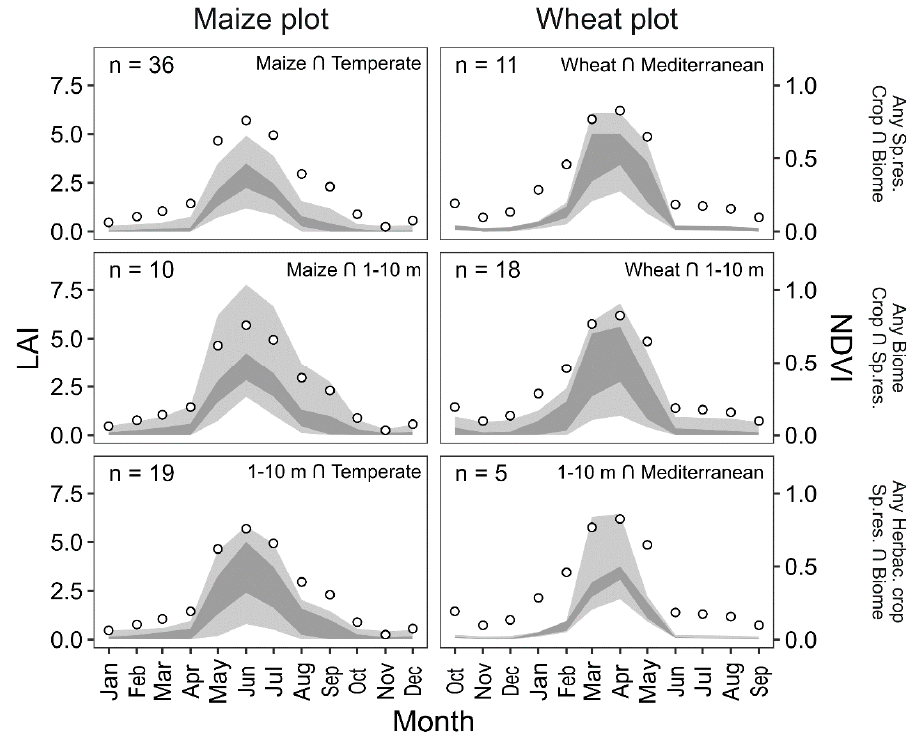
Figure 5. Leaf area index (LAI) seasonal profile of the case studies, computed from normalized difference vegetation index (NDVI, dots) values according to the equations derived from the following combinations of attributes: ( top ) crop- and biome-specific equations; ( middle ) crop- and spatial resolution-specific equations; ( bottom ) biome- and spatial resolution-specific equations. The grey shadows indicate the 5–95th (light grey) and the 25–75th percentile (dark grey) of the LAI values obtained from the equations considered.